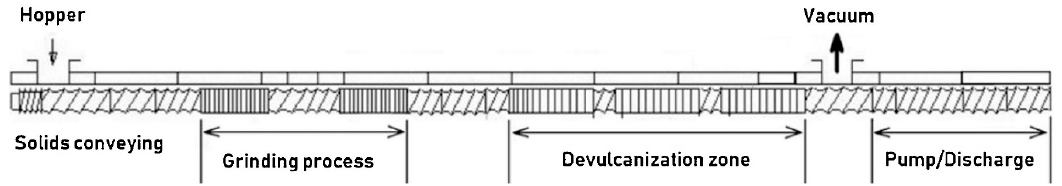
Figure 12. A typical screw configuration for GTR regeneration showing the different processing sections (reproduced with permission from [66]).